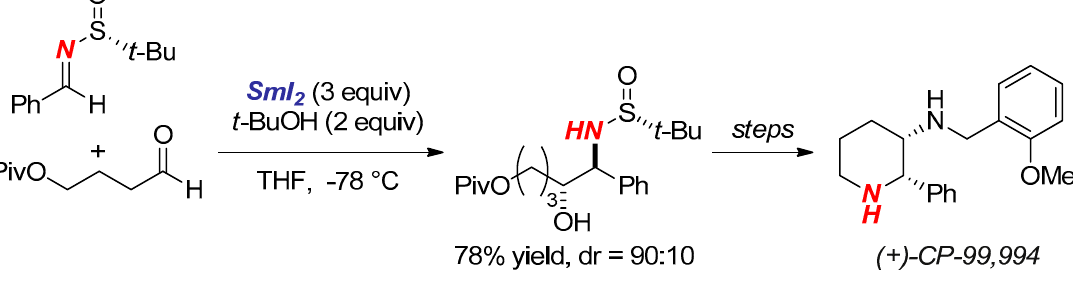
Scheme 11. Synthesis of (+)-CP-99,994 by Cross-Coupling of N- tert -Butanesulfinyl Imines.